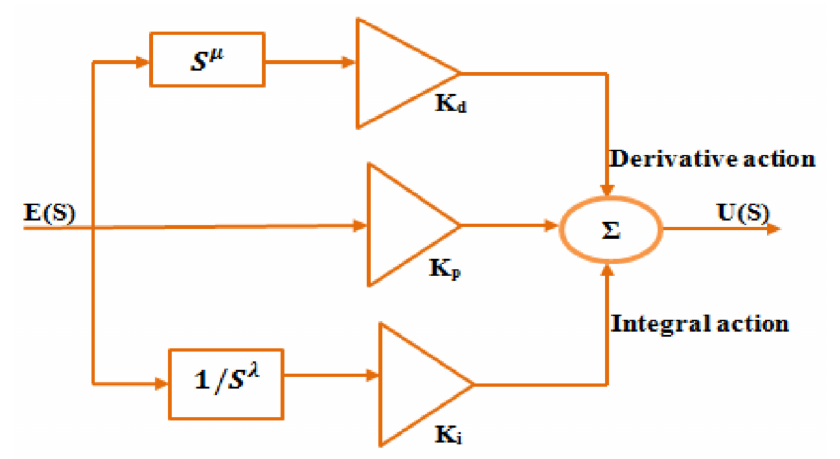
Figure 3. Block diagram of FOPID